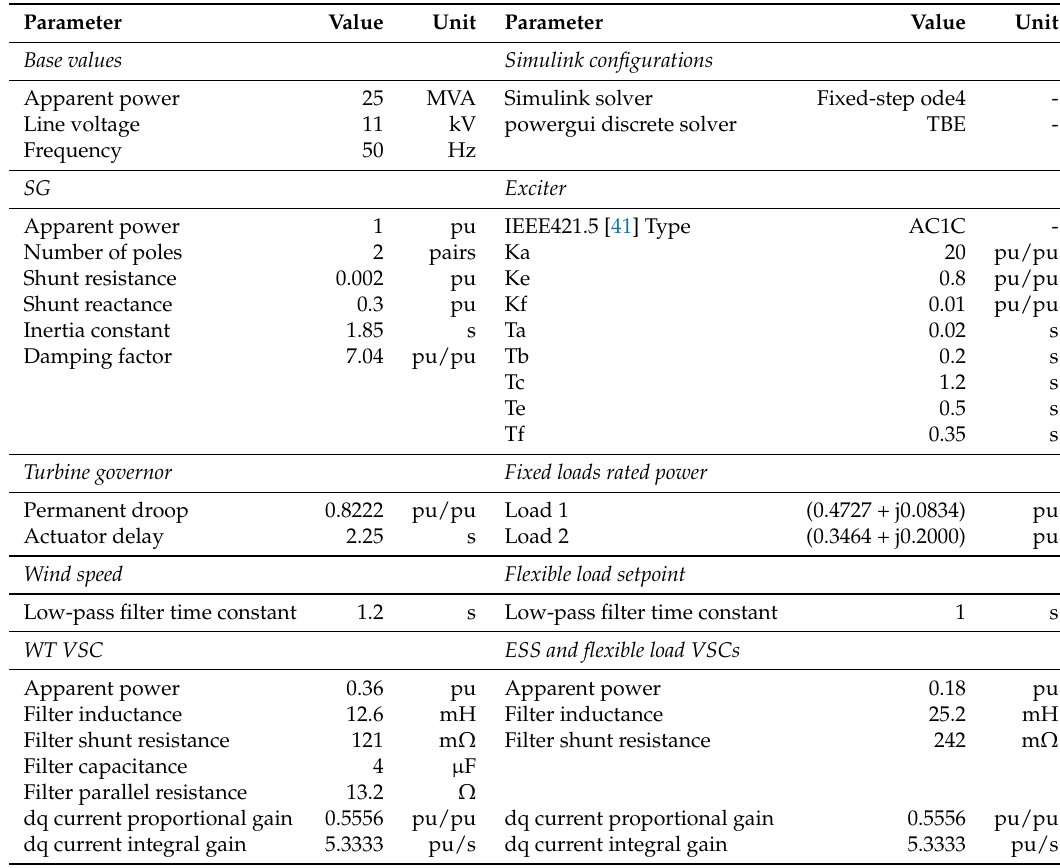
Table A1. Summary of the model parameters for the case